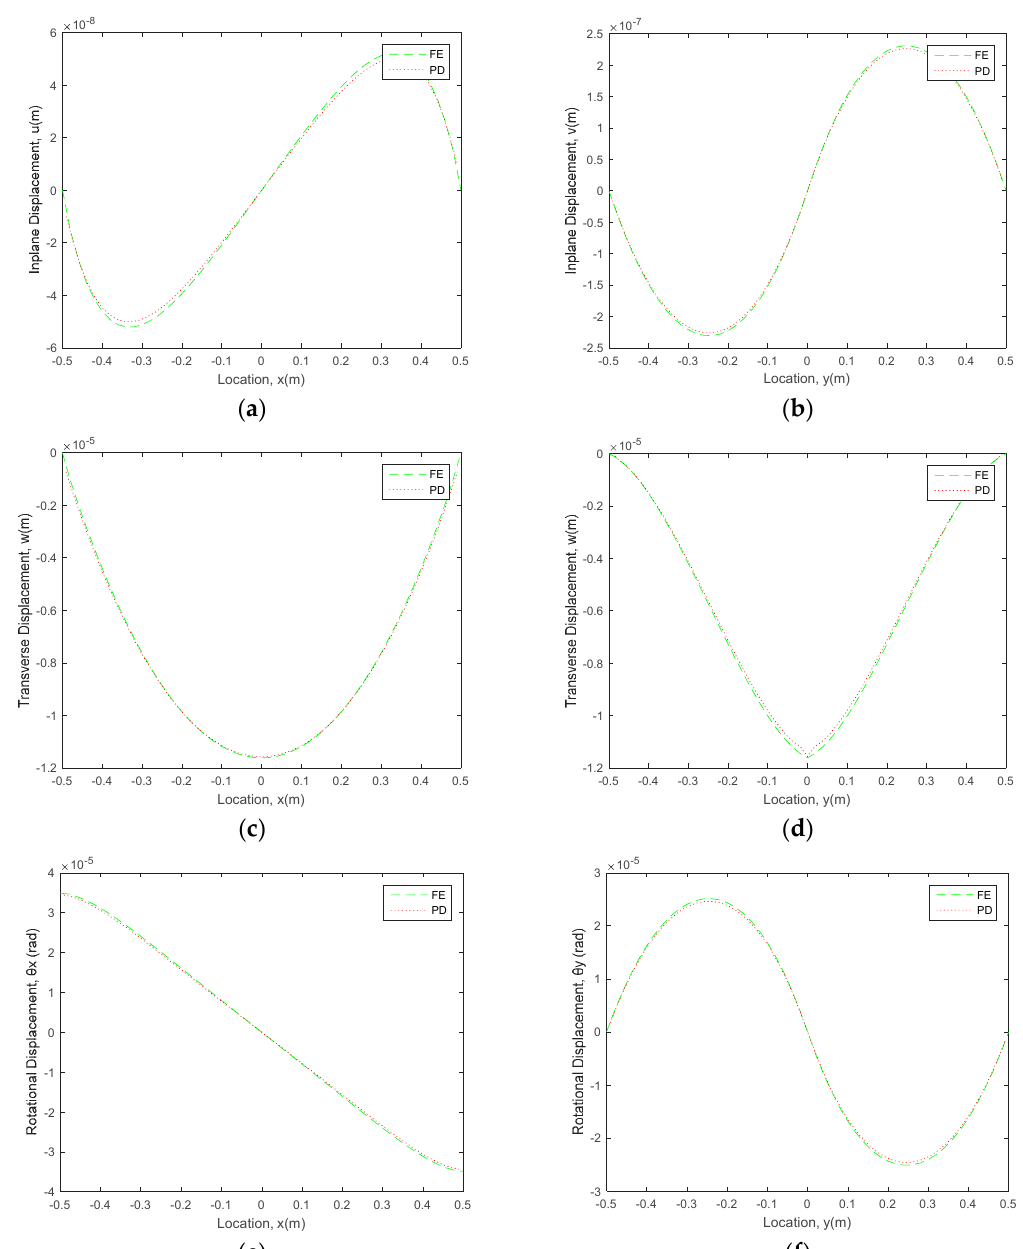
Figure 10. Comparison of PD and FEA results along the central x - and y -axes.